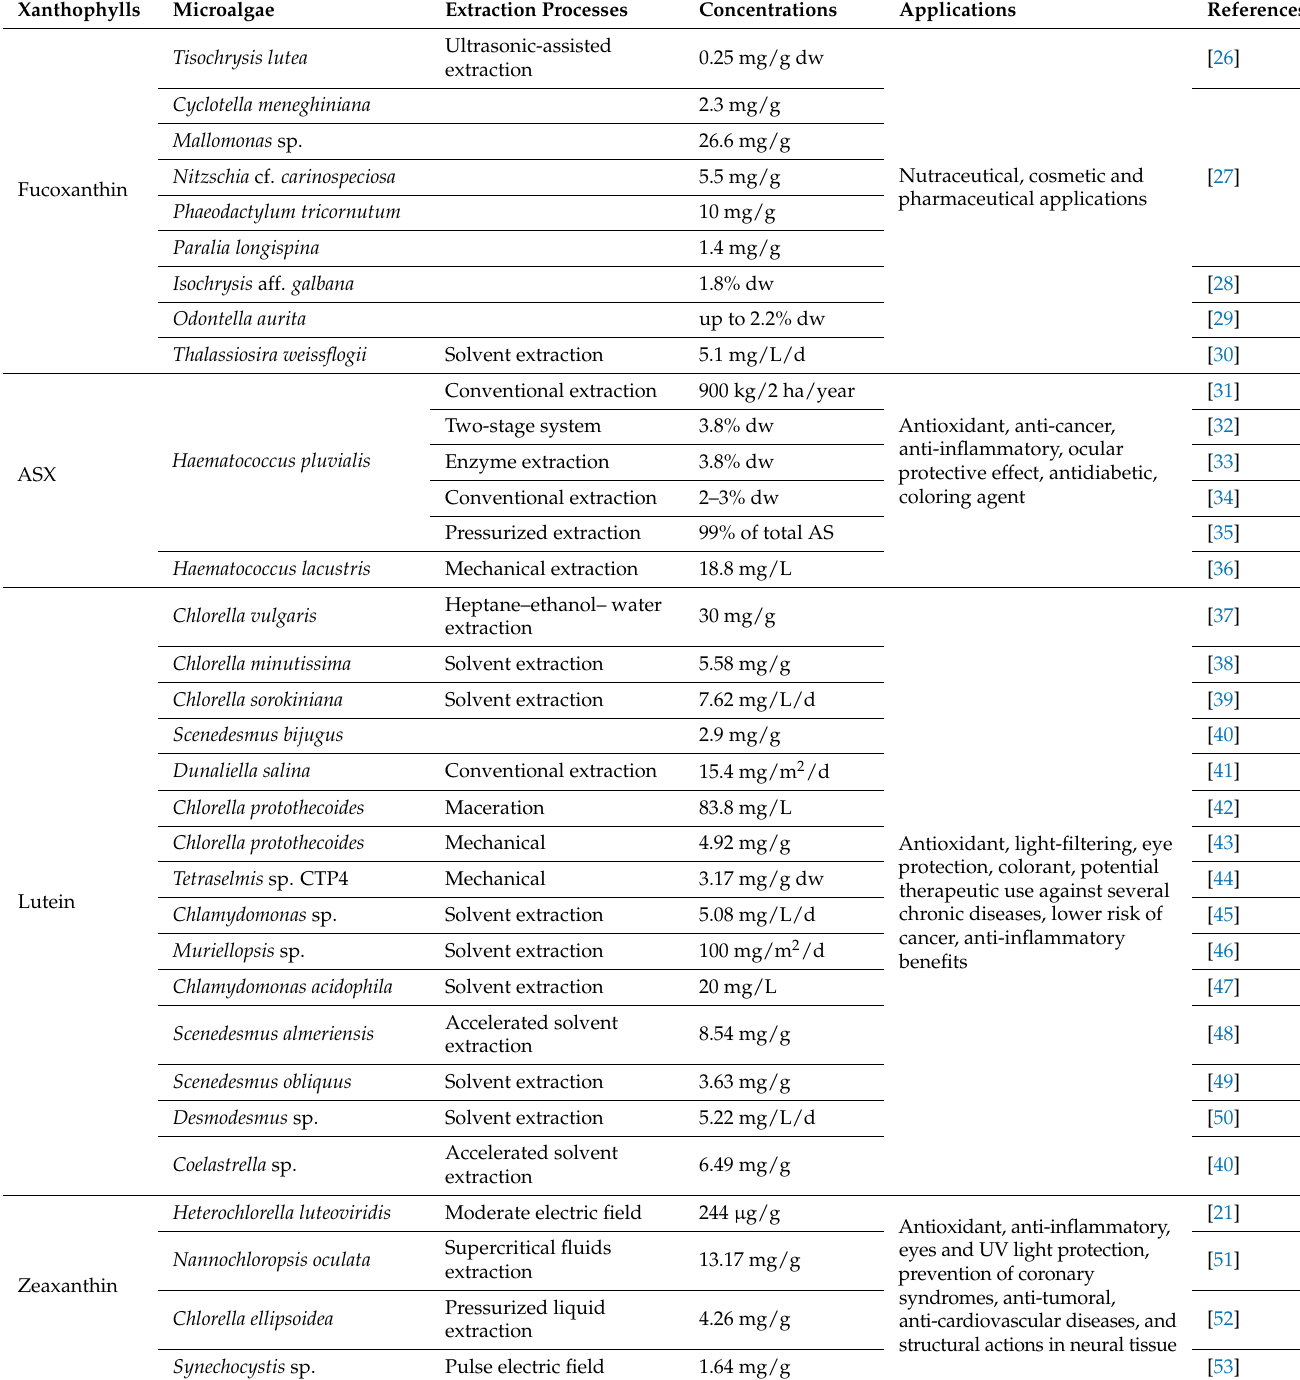
Table 1. Xanthophylls from microalgae: mass production, extraction method and application. Xanthophylls